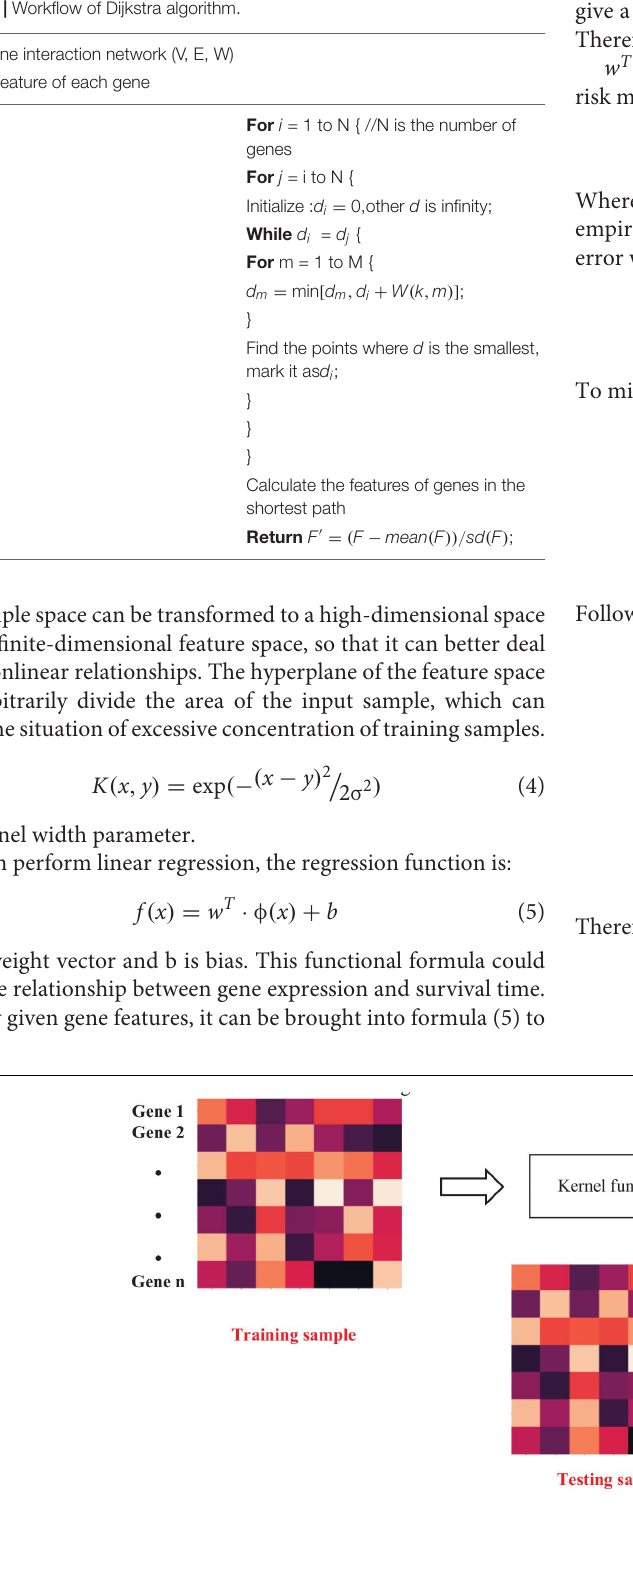
Frontiers in Cell and Developmental Biology |